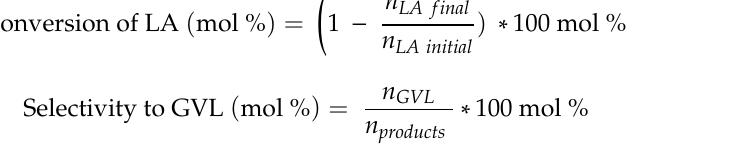
Figure S1: XPS profiles of reduced catalysts. Figure S2: H 2 -TPD profiles of the synthesized SBA-15 supported catalysts. Figure S3: Influence of metals supported with SBA-15 on the amount of hydrogen in gas. Figure S4: GC-MS results for hydrogenation of LA with di ff erent reaction